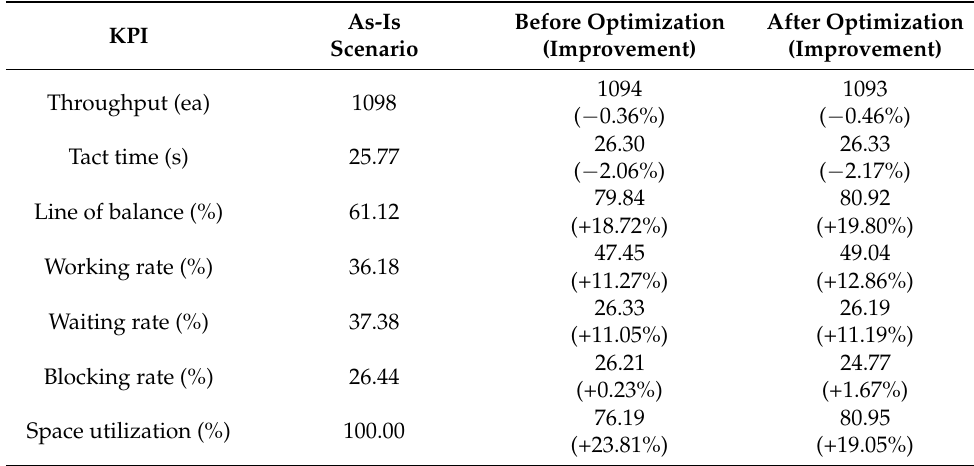
Figure 7. Layout image after optimization. Table 7. Results of Experiment